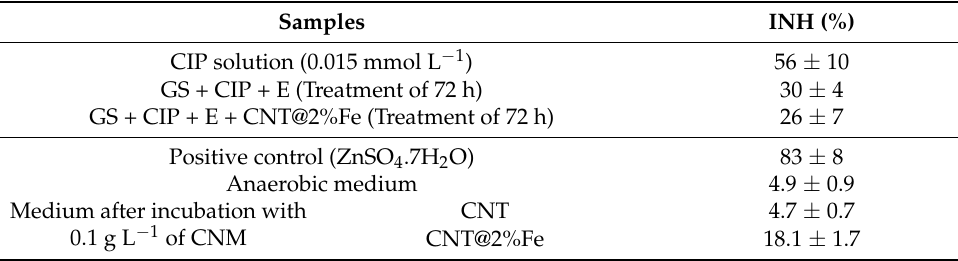
Table 5. Luminescence inhibition (INH) of V. fischeri in all the tested samples, after 30 min of exposure.